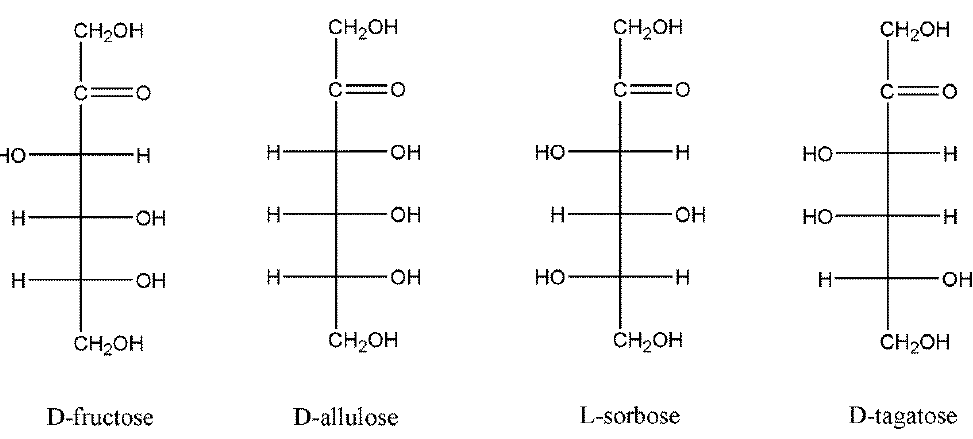
Figure 7. Fischer projection formulas of D-fructose, D-allulose, L-sorbose, and D-tagatose.